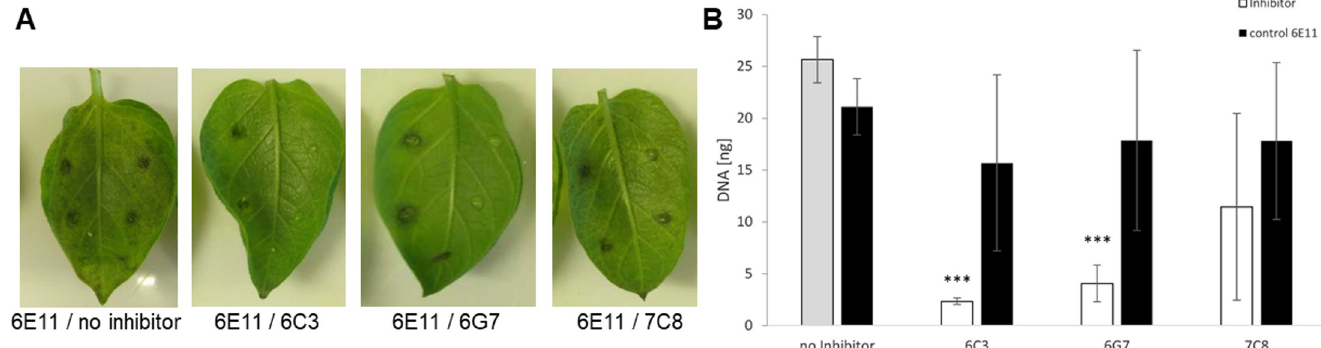
Fig 3. The inhibitory effects of the compounds on the growth of the pathogen Phytophthora infestans . (A) P . infestans growth on potato leaves ( Solanum tuberosum ). Each potato leaf was inoculated with both 1 mM of the control compound 6E11 (left half of the leaf) and 1 mM of the test compound (right half of the leaf). The leaves are representatives of ten repetitions, each conducted in parallel (applied on the top and the bottom of the leaf). (B) Quantification of P . infestans growth on potato leaves 4 days after infection by real-time PCR. ��� P < 0.001 between the test and control compound; Student’s